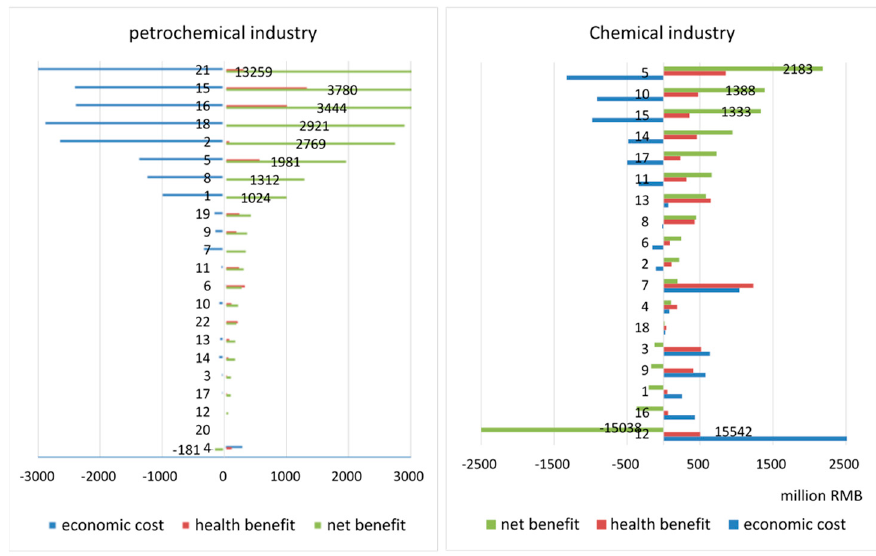
Figure 9. Economic cost, health benefit and net benefit.